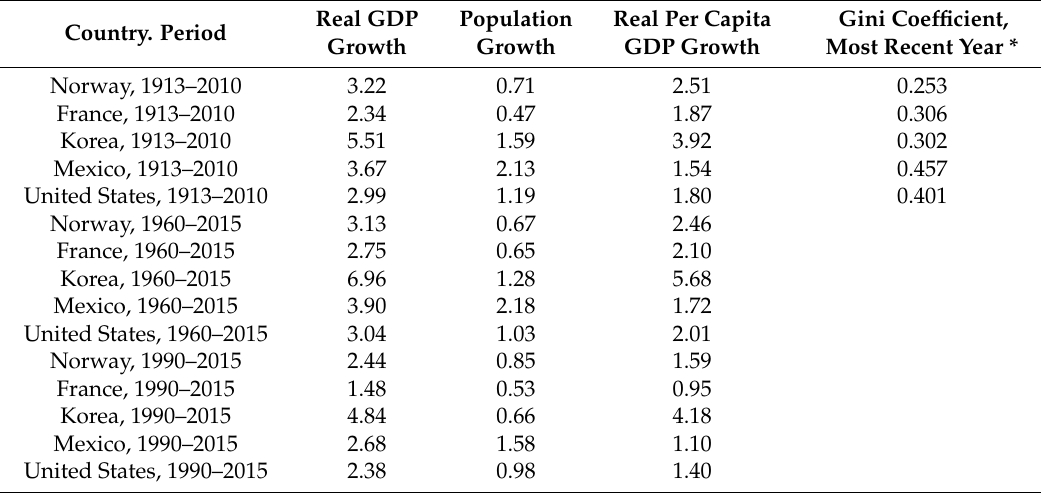
Table 2. Average Annual Real GDP Growth, Population Growth and Real Per Capita GDP Growth in Selected Countries over Various Periods of Time (percent) and recent Gini